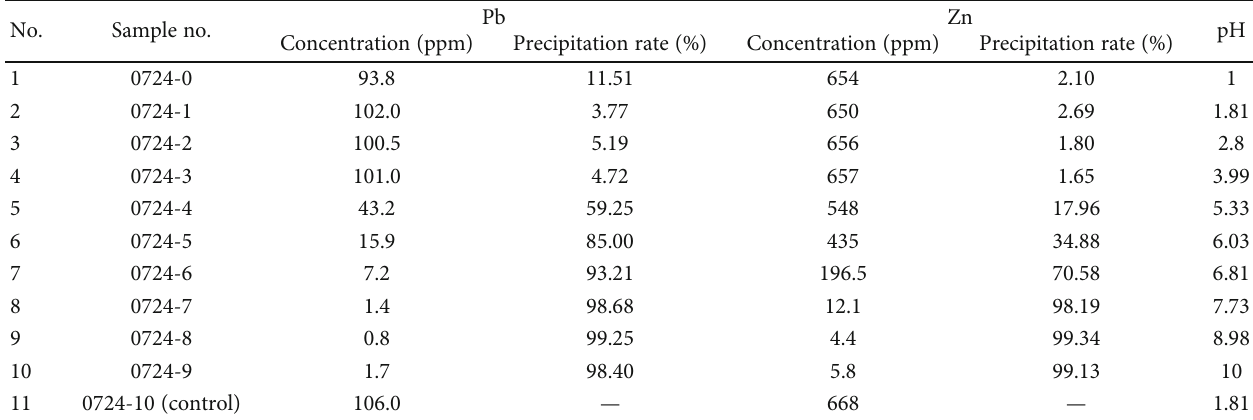
Table 4: E ff ect of pH on mixed solution ②